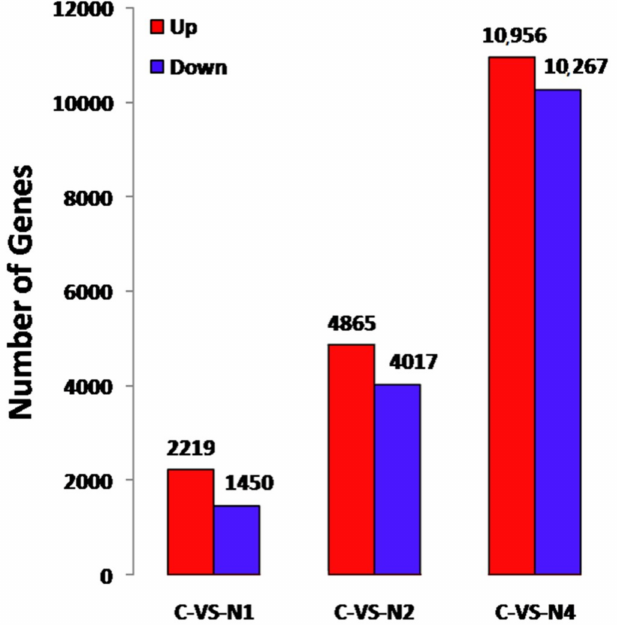
Figure 3. Comparison of up and down-regulation of DEGs. C-vs-N1, C-vs-N2 and C-vs-N4 representing the DEUs under the exposure time of 12 h, 24 h and 48 h in NaCl solution,